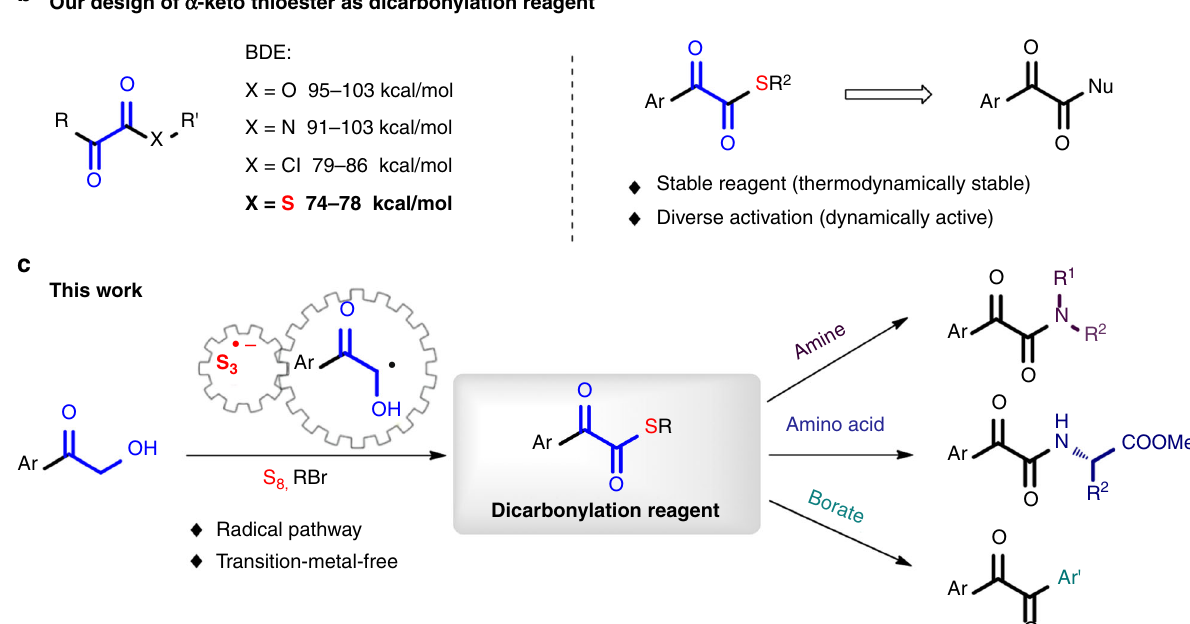
Fig. 2 Strategies for the design of a 1,2-dicarbonyl-forming reagent and its applications. a The role of thioesters in life and biomimetic synthesis. b The strategy of α -ketothioester as dicarbonyl reagent. c Metal-free synthesis of an α -ketothioester reagent and its